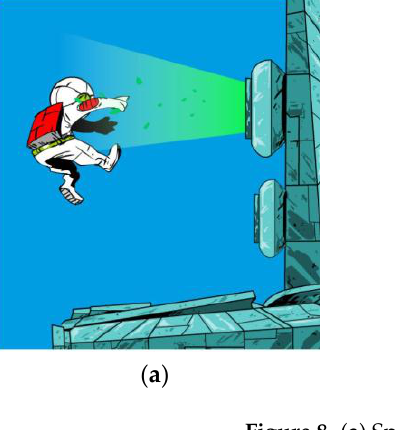
Figure 8. ( a ) Space Kids and ( b ) Puzzle City 2.